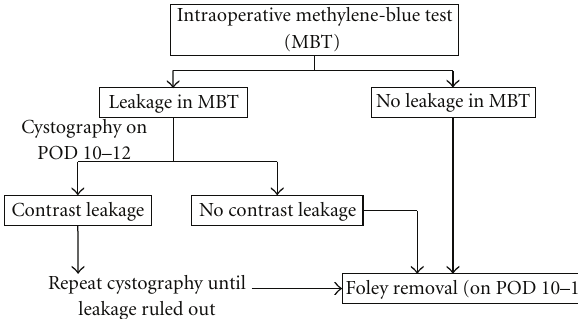
Figure 3: Algorithm for routine workup after intraoperative methylene blue test